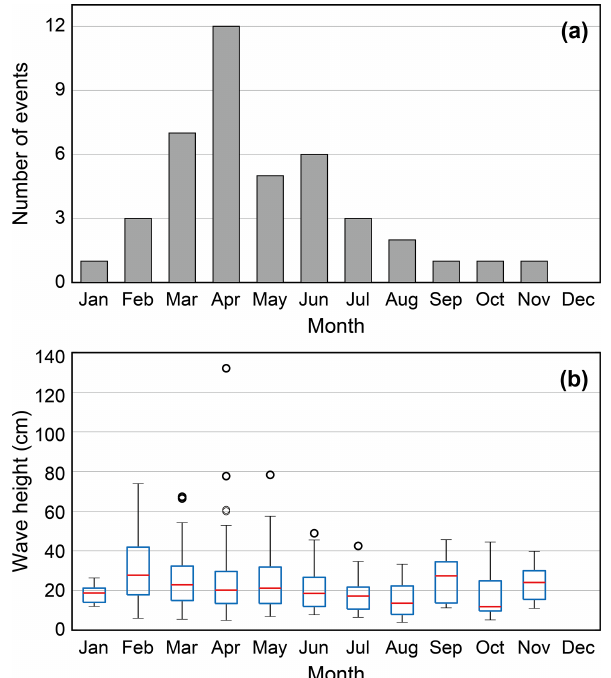
Figure 5. Temporal pattern of meteotsunami occurrences: (a) num- ber of events and (b) distribution of wave height per month.